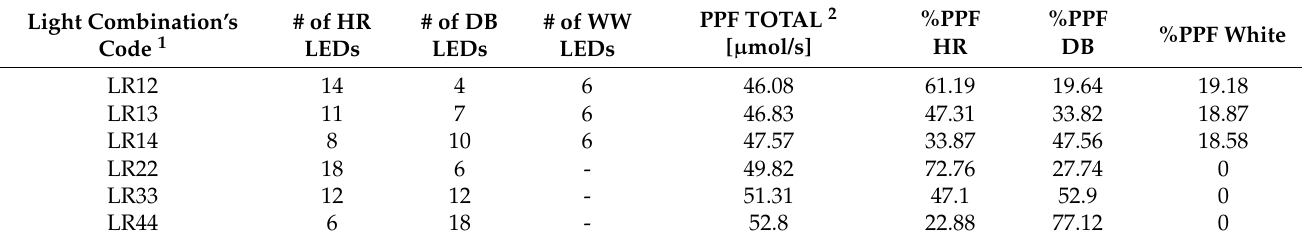
Table 7. Summary of LEDs composition for each considered light combination and corresponding Photosynthetic Photon Flux